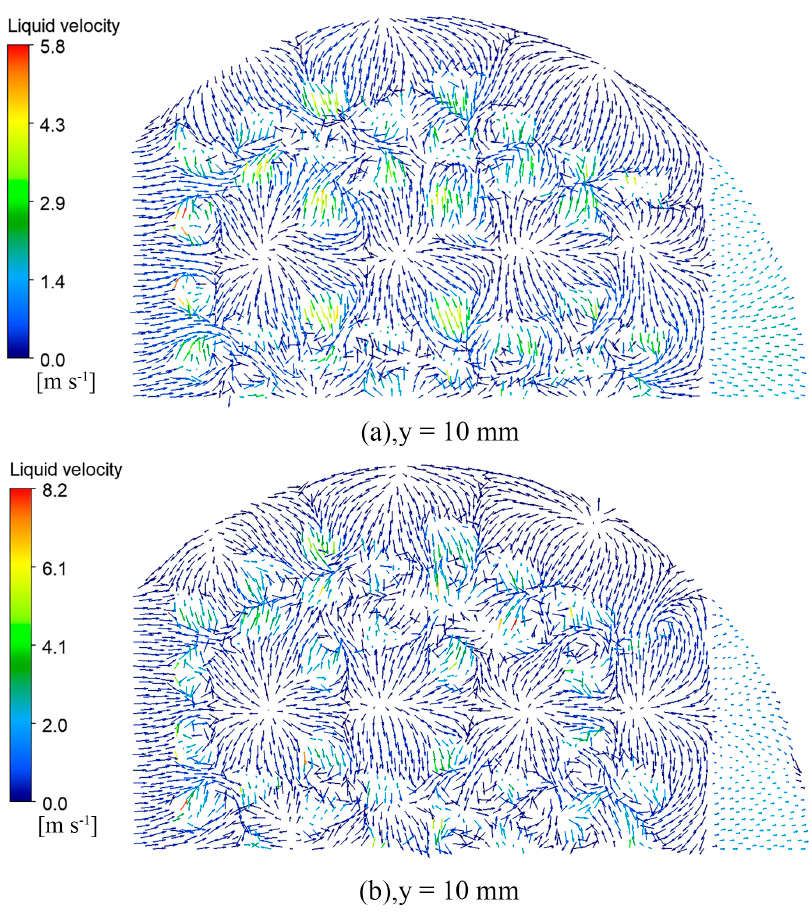
Figure 14. Liquid velocity vector snapshots of the top view at y = 10 mm: ( a ) rectangular guided valve tray; ( b ) parabolic–shaped guided valve tray.